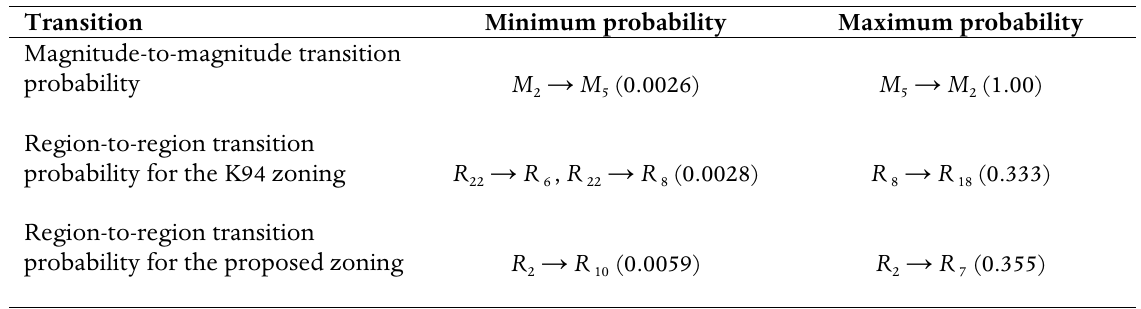
Table 2. Summary of minimum and maximum transition probabilities.